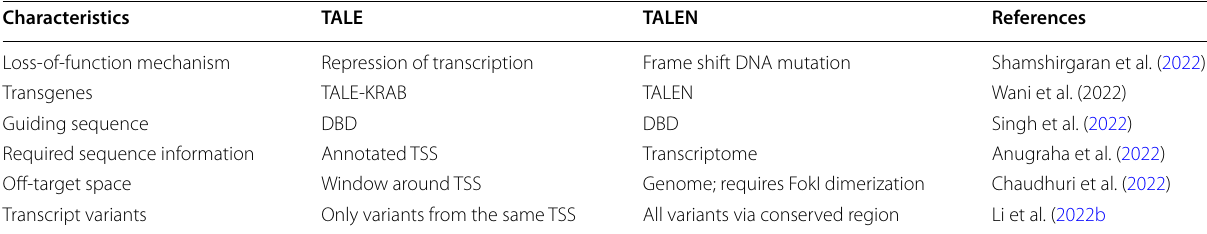
Table 3 Comparisons between TALEs and TALENs